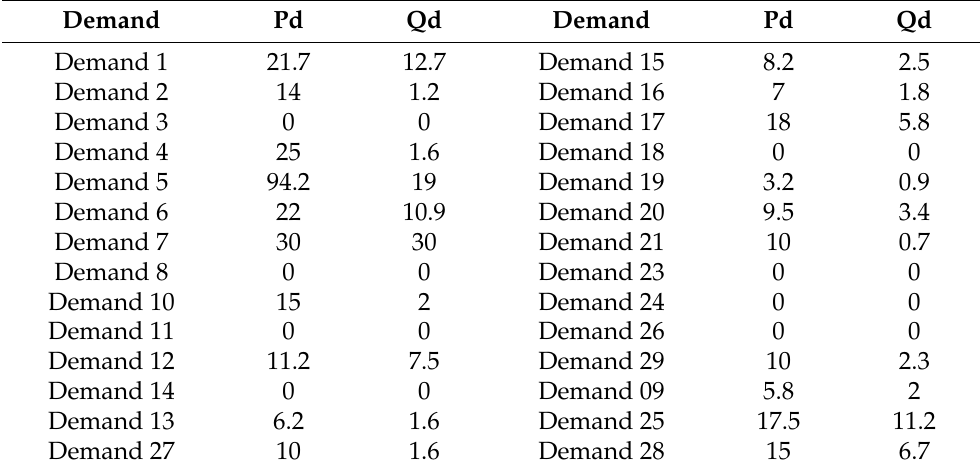
Table 1. Demand data.